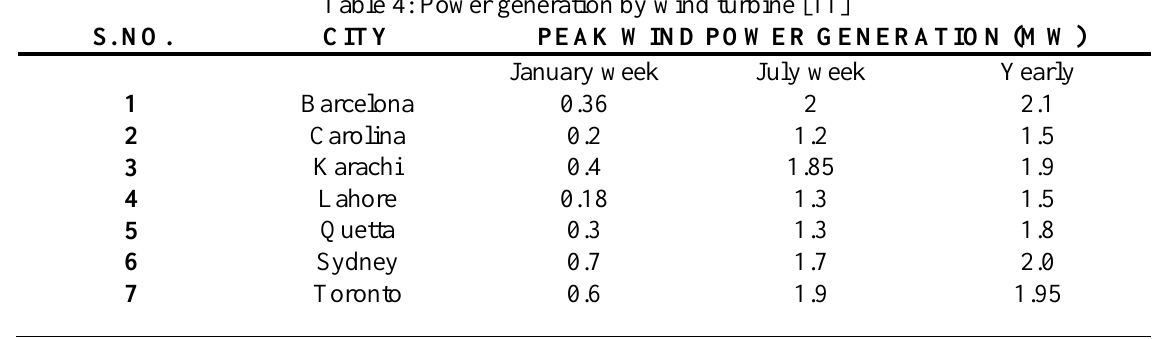
Table 4: Power generation by wind turbine